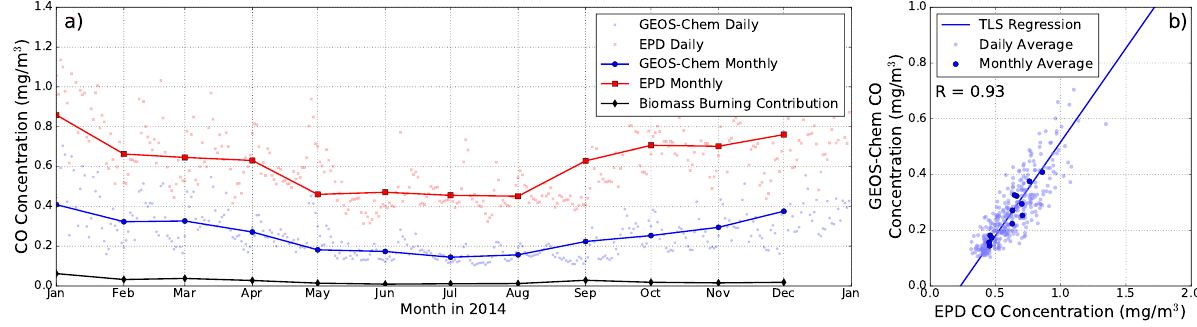
Figure 4. (a) Time series of the GEOS-Chem simulation and the air quality monitoring network measurement of ambient CO concentrations in Hong Kong. The contribution of biomass burning CO is also shown for reference. (b) Comparison of GEOS-Chem simulation and air quality monitoring network measurement of ambient CO concentrations in Hong Kong. Daily and monthly average data are shown. The total least squares regression line is calculated based on the monthly average